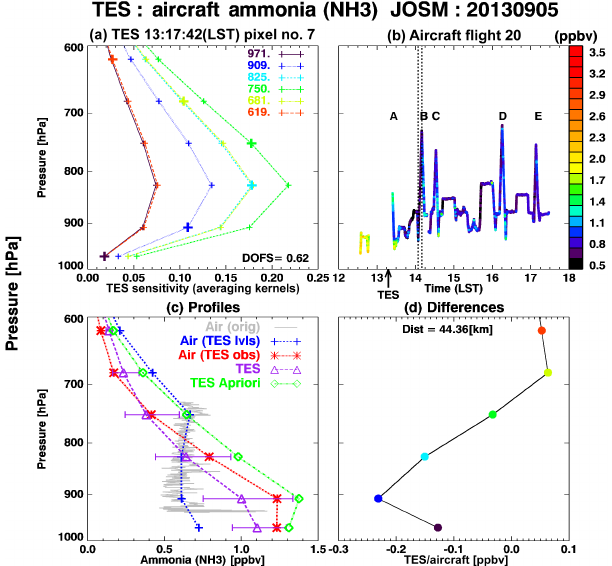
Figure 9. Representative single NH 3 profile aircraft/satellite com- parison and associated plots. Similar to Fig. 3, but this is example profile “B” of NH 3 from the transformation flight 20, compared with pixel 7 from the TES transect.